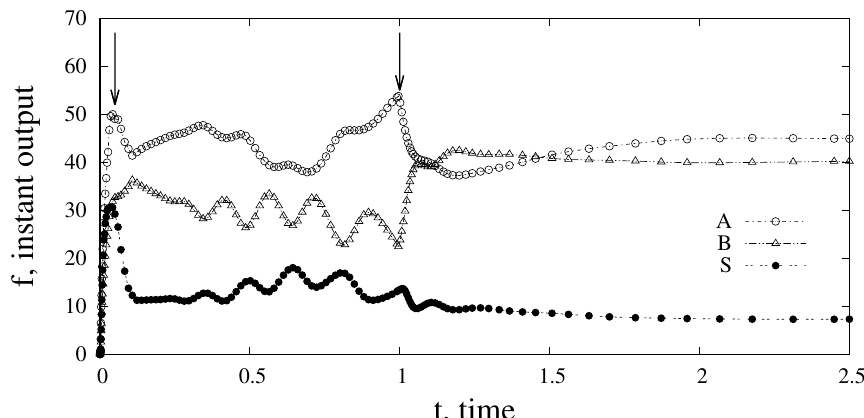
Figure 6. Output from a continuous-flow reactor with walls being tuned in real-time. The time intervals [ 0,0.05 ] , [ 0.05,1 ] and [ 1,2.5 ] correspond to the three Hele-Shaw cell configurations shown in Figure 5, respectively. Switches between configurations are indicated by